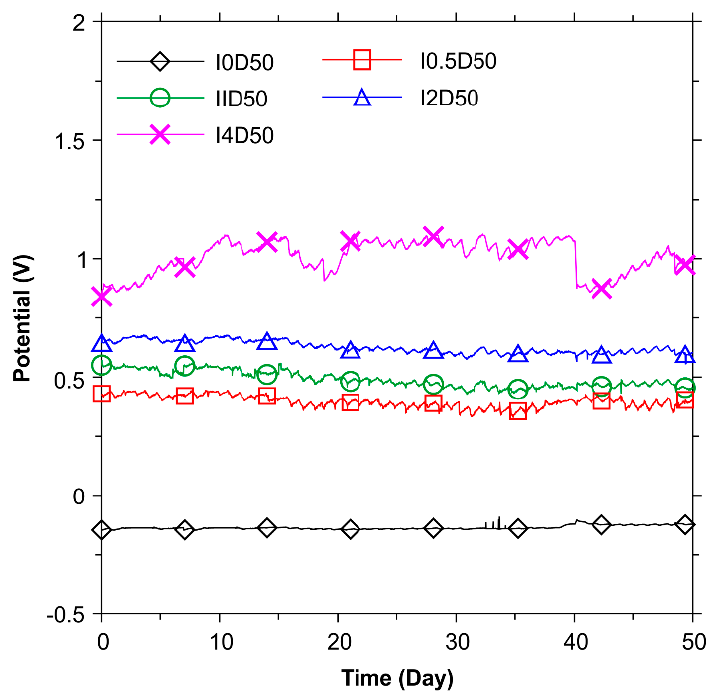
Figure 4. Results of CFRP potential (vs. saturated calomel electrode (SCE)) in the galvanostatic anodic polarization tests.